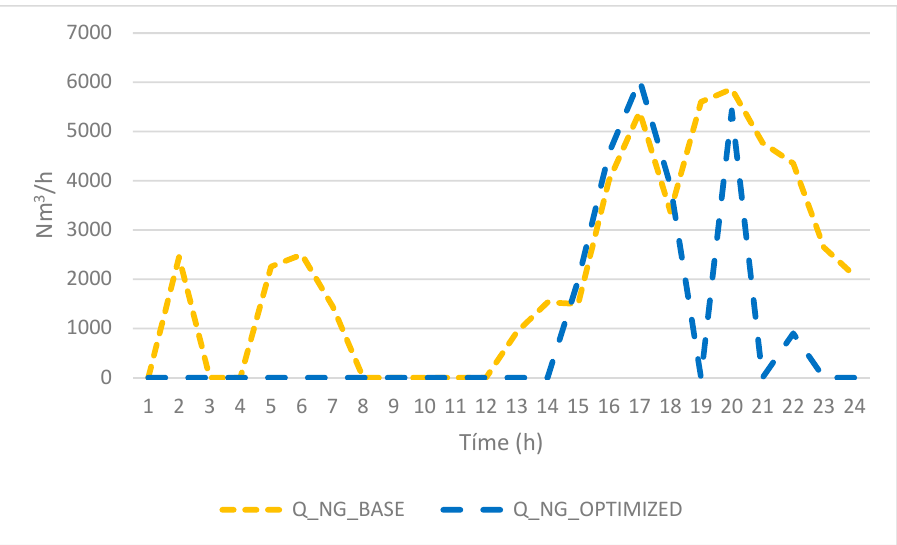
Figure 10. Base and optimized distribution NG for steam production in the planning period.